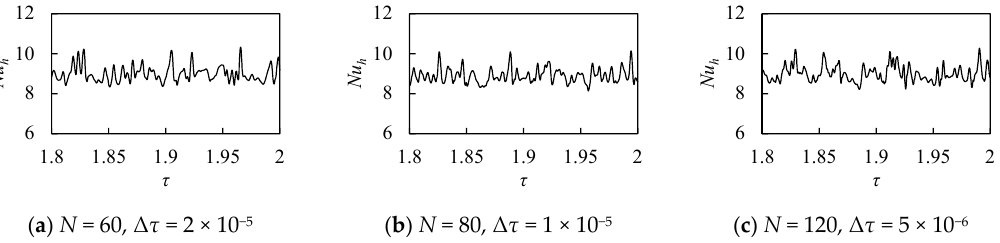
Figure 5. Time development of Nu h with non-uniform grids at Pr = 0.025, κ = 0.5, Ra = 10 7 , and Ha = 0.